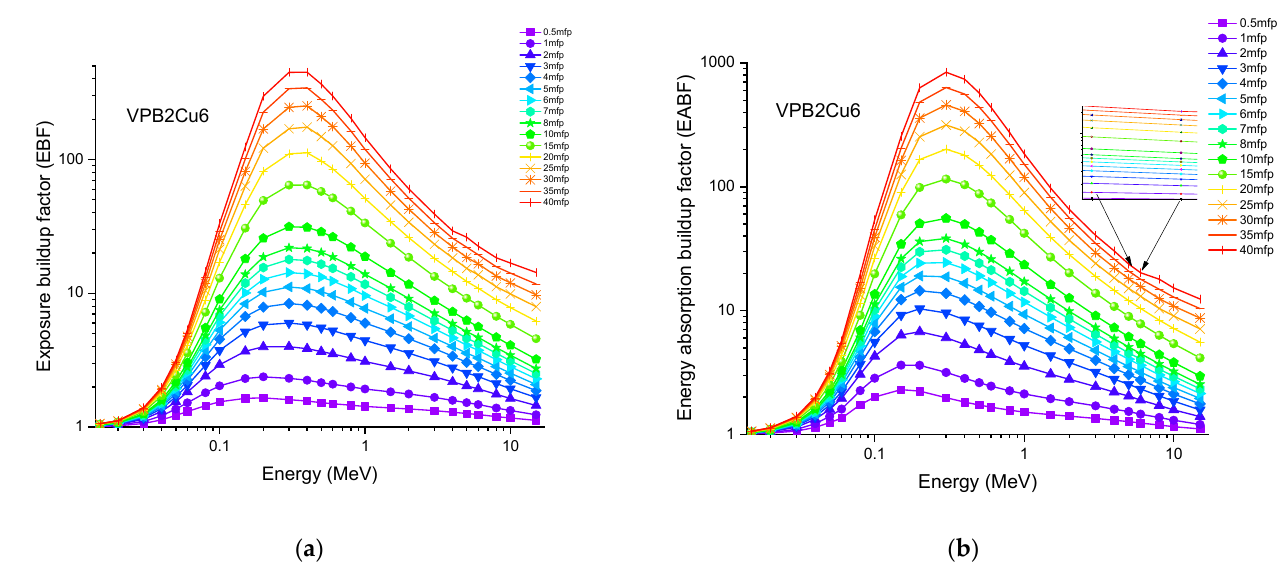
Figure 13. Variation of ( a ) EBF and ( b ) EABF against photon energy for sample VPB4Cu4.